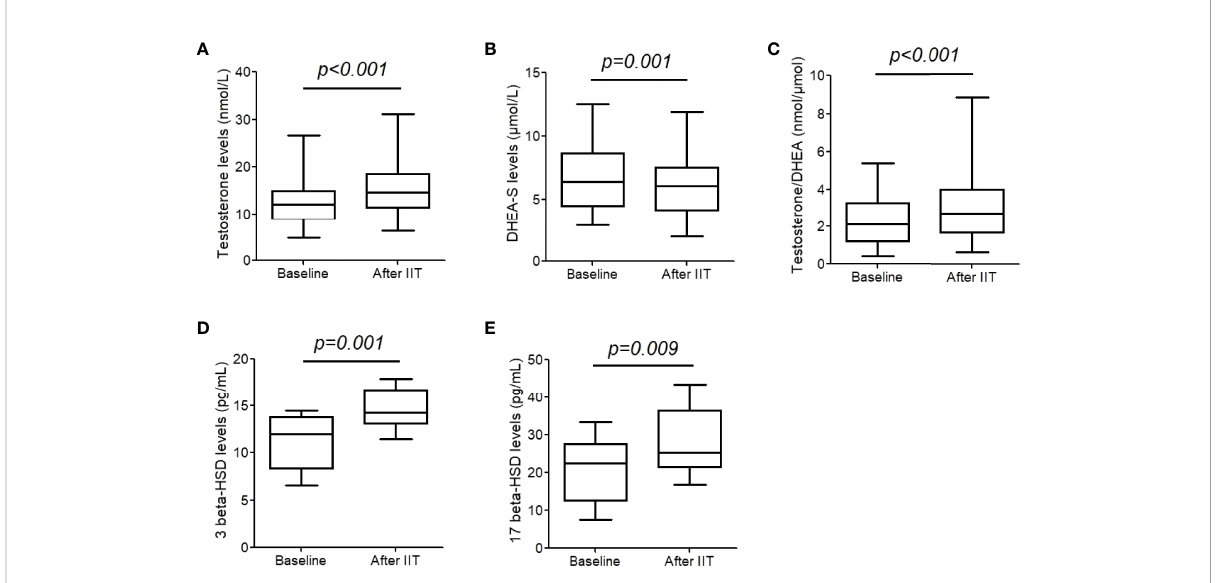
FIGURE 1 Testosterone, dehydroepiandrosterone sulfate (DHEA-S), and 3/17 b -hydroxysteroid dehydrogenase (HSD) levels before and after intensive insulin therapy (IIT). (A-C) testosterone and DHEA-S levels were measure in 43 patients with T2DM. (D, E) 3/17 b - HSD levels were measured in 17 patients. The differences between two groups were analyzed were assessed by a paired t-test. The whiskers of the box were showed as 5 – 95